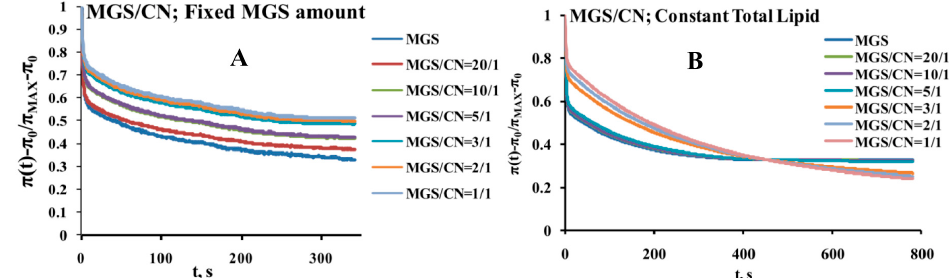
Figure 6. Surface pressure stress-relaxation transients of pseudo binary MGS/CN layers.